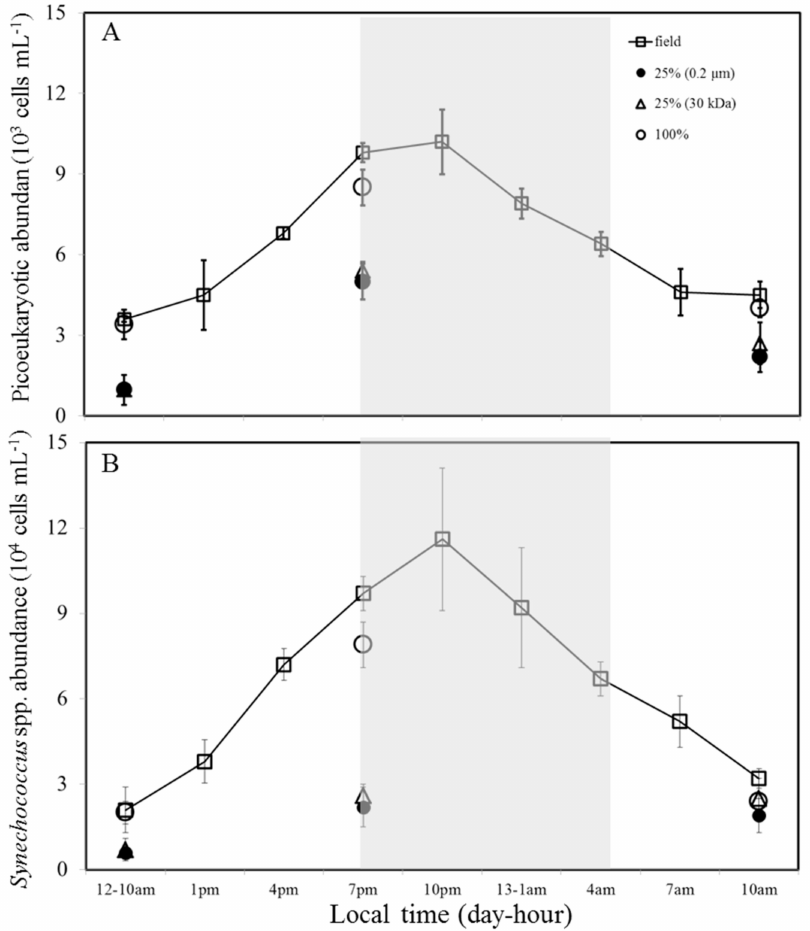
Figure 1. Diel variations of in situ picoeukaryotic ( A ) and Synechococcus spp. ( B ) abundance ( □ , solid line) in collected water samples at the beginning (10 am), dusk (19 pm), and the end of the experiment (24 h) in 0.2 μ m fi ltered ( ● ), 30 kDa filtered ( △ ), and non-filtered ( o ＊ ) treatments, respectively. The grey area represents the night period. Error bars represent the SD estimated from triplicate measurements.